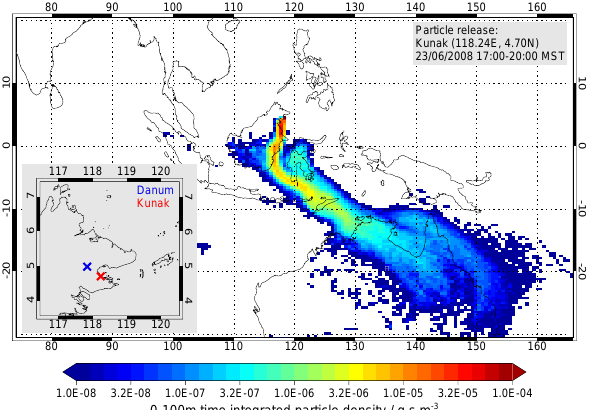
Fig. 5. Emission map for NAME forward run. To determine the emitting regions, the calculation presented in Fig. 4 was repeated for each day between 10 June and 31 July 2008 (approximately covering the period of our OP3 measurements). Grid boxes with a mean time integrated particle density greater than an arbitrary limit were selected. A 4km resolution land-sea mask was then used to find coastlines within the selected grid boxes. These coastlines were then split in to 13 regions and populated with overlapping 0.1 ◦ emission squares. Inset: Danum (blue) and Kunak (red) are repre- sented by 0.2 ◦ squares in the NAME model; Kunak contains emit- ting squares belonging to region 3.